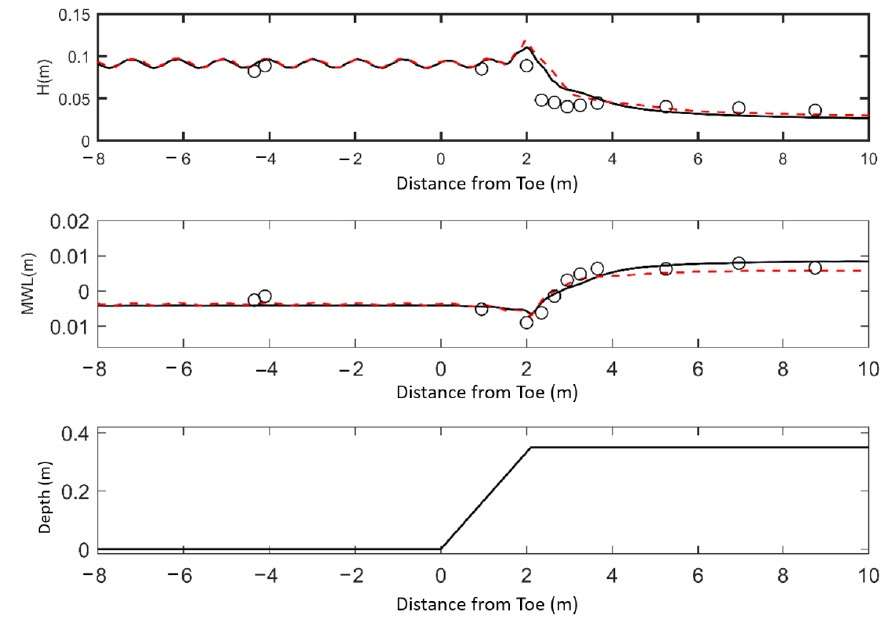
Figure 2. Variation of wave height and mean water level over the reef profile for Case 1. Figure 11 Black solid line: predictions by present model; red dashed line: predictions by Yao; open circles: laboratory measurements. Water 2018 , 10 , 1147